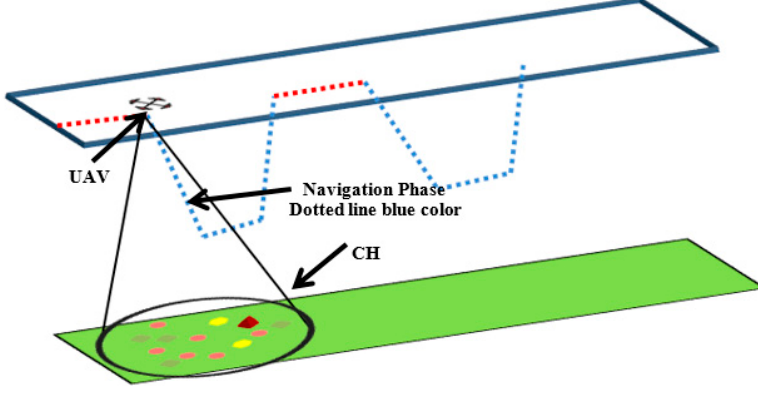
Figure 7. Navigation phase of the proposed system.